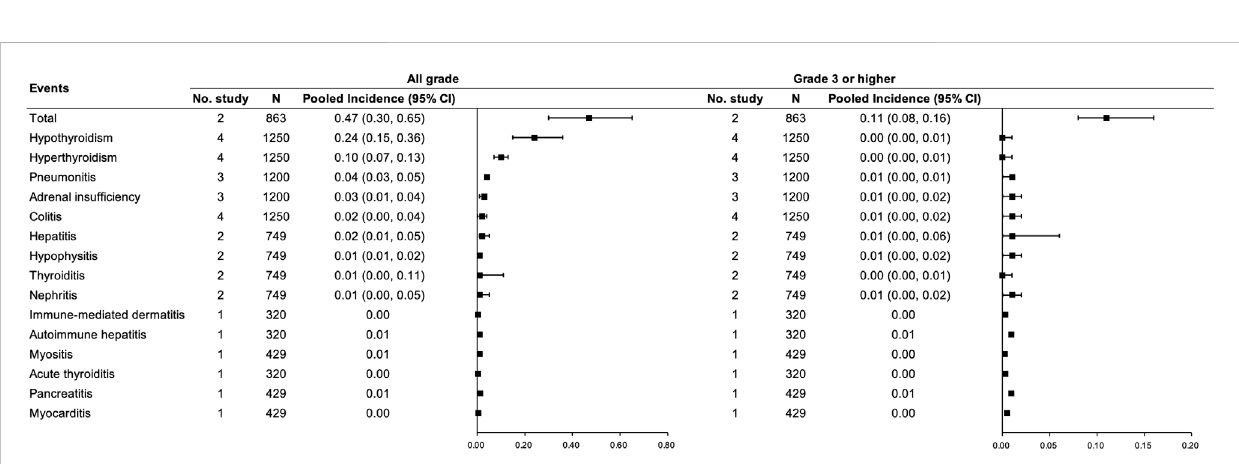
FIGURE 3 Incidence of irAEs for PD-(L)1 inhibitors combined with anti-VEGF(R) agents therapy. Note: an incidence of 0.00 indicates a rate <